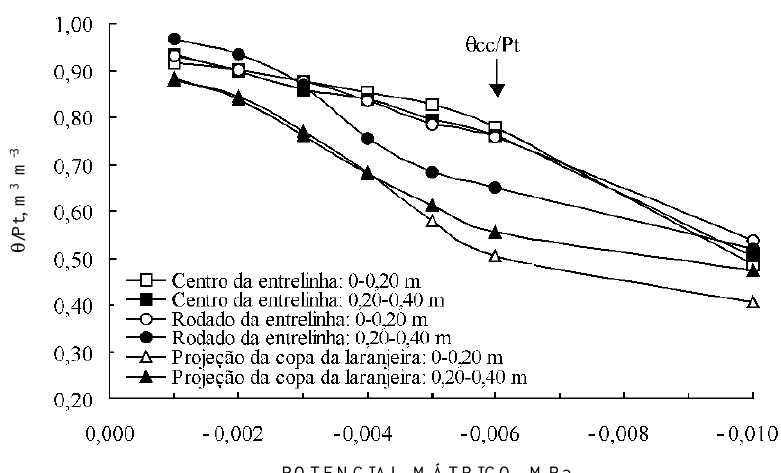
POTENCIAL MÁTRICO, Figura 3. Saturação relativa do solo ( θθθθθ /Pt) em diferentes potenciais mátricos de um Latossolo Vermelho distrófico cultivado com laranjeira Valência, nas posições de amostragem (copa da laranjeira, rodado da entrelinha e centro da entrelinha) e camadas (0–0,20 e 0,20–0,40 m). θθθθθ cc/Pt indicado pela seta corresponde ao indicador de qualidade física do solo proposto por Reynolds et al. (2002).